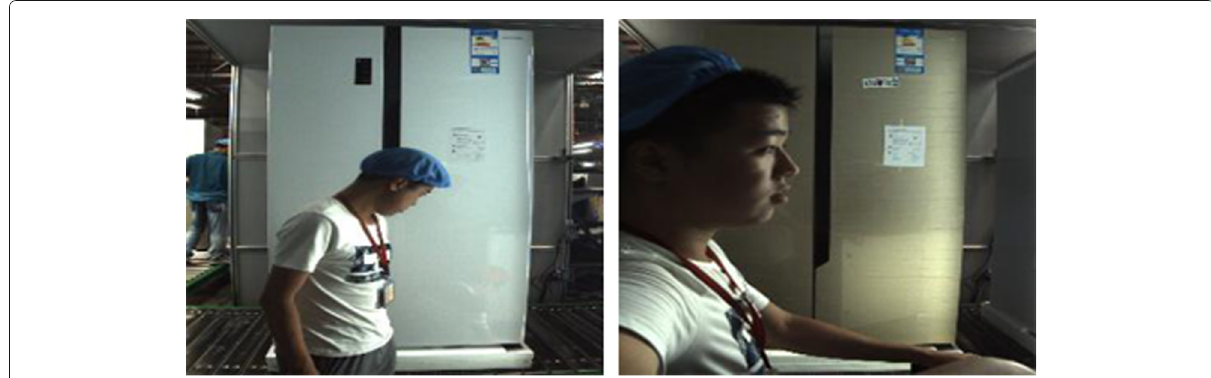
Fig. 9 The testing data with different artifacts